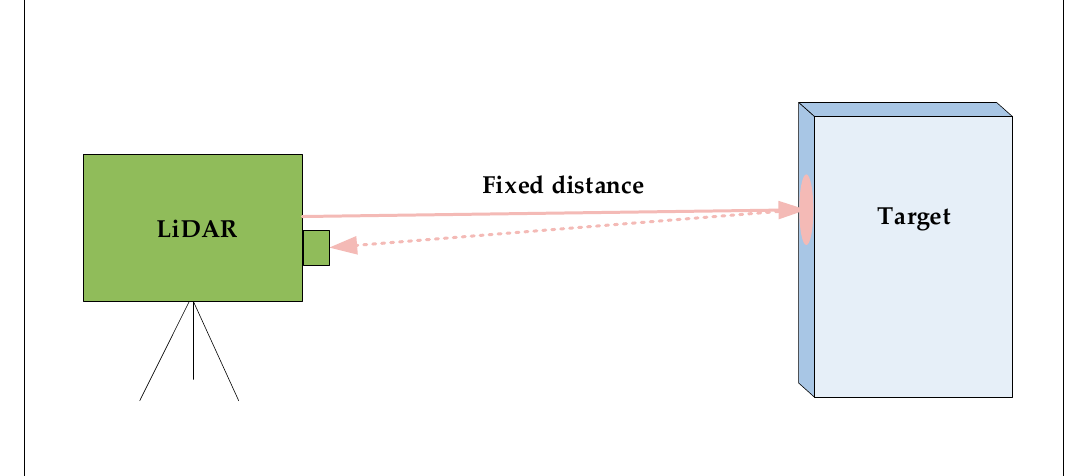
Figure 5. Laboratory test of laser echo signal.